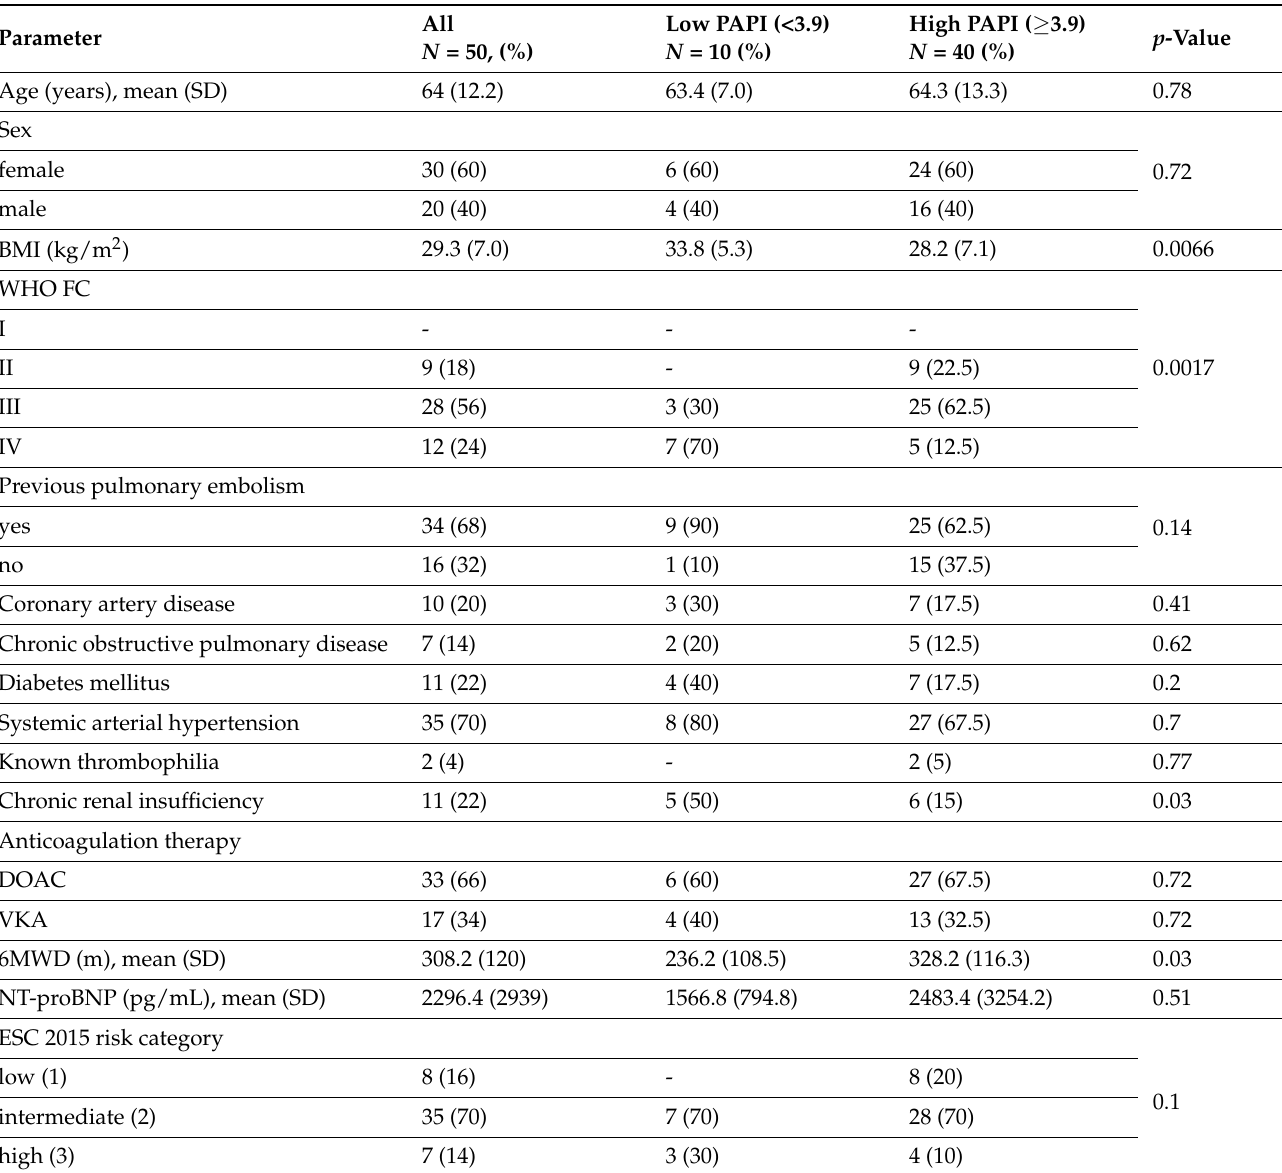
Table 1. Demographic and clinical characteristics of the study population according to pulmonary artery pulsatility index-based risk